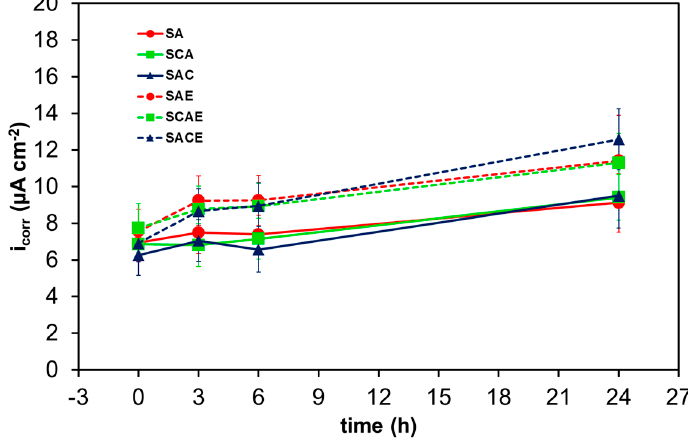
Figure 8. Average corrosion current density ( i corr ) of the different AA6012 samples in aerated solution as a function of exposure time.